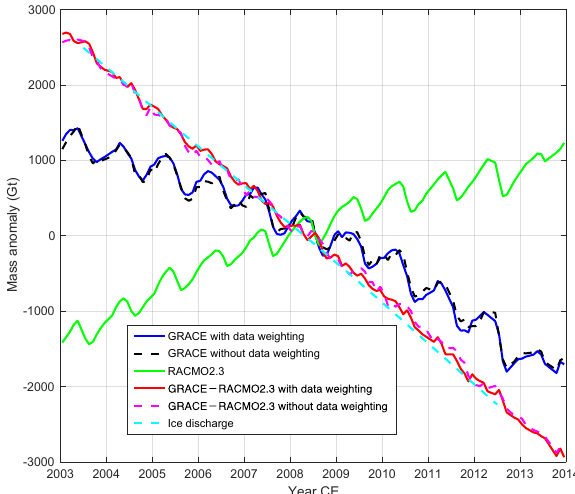
Figure 2. Time series of mass anomalies over the period 2003–2013 for the entire GrIS: total mass anomalies from GRACE produced with and without data weighting (solid blue and dashed black, re- spectively), cumulative SMB anomalies from RACMO2.3 (green), the difference between them, the “total–SMB” residuals (solid red and dashed pink: with and without data weighting, respectively), and cumulative ice discharge